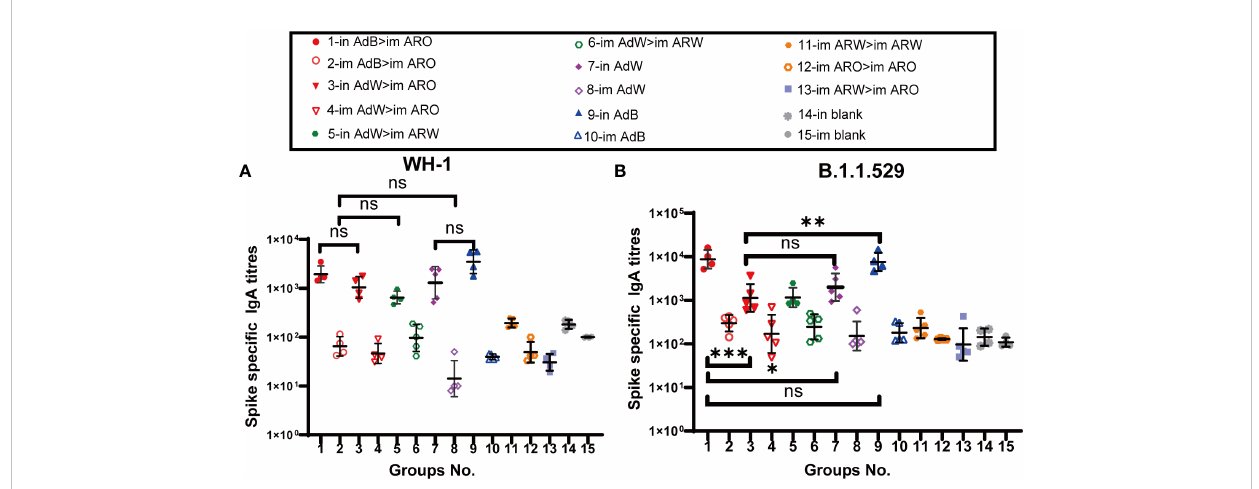
FIGURE 5 IgA responses induced by AdW, AdB, ARW, and ARO vaccines were administered using various protocols. All titres were measured on day 35 after primary immunisation. Serum IgA titres against (A) WH-1 and (B) B.1.1.529 spike protein (n = 4 − 5 per group; each spot represents one sample). Bars represent the geometric mean ± geometric SD; *P < 0.05; **P < 0.01; ***P < 0.001; ns, P >